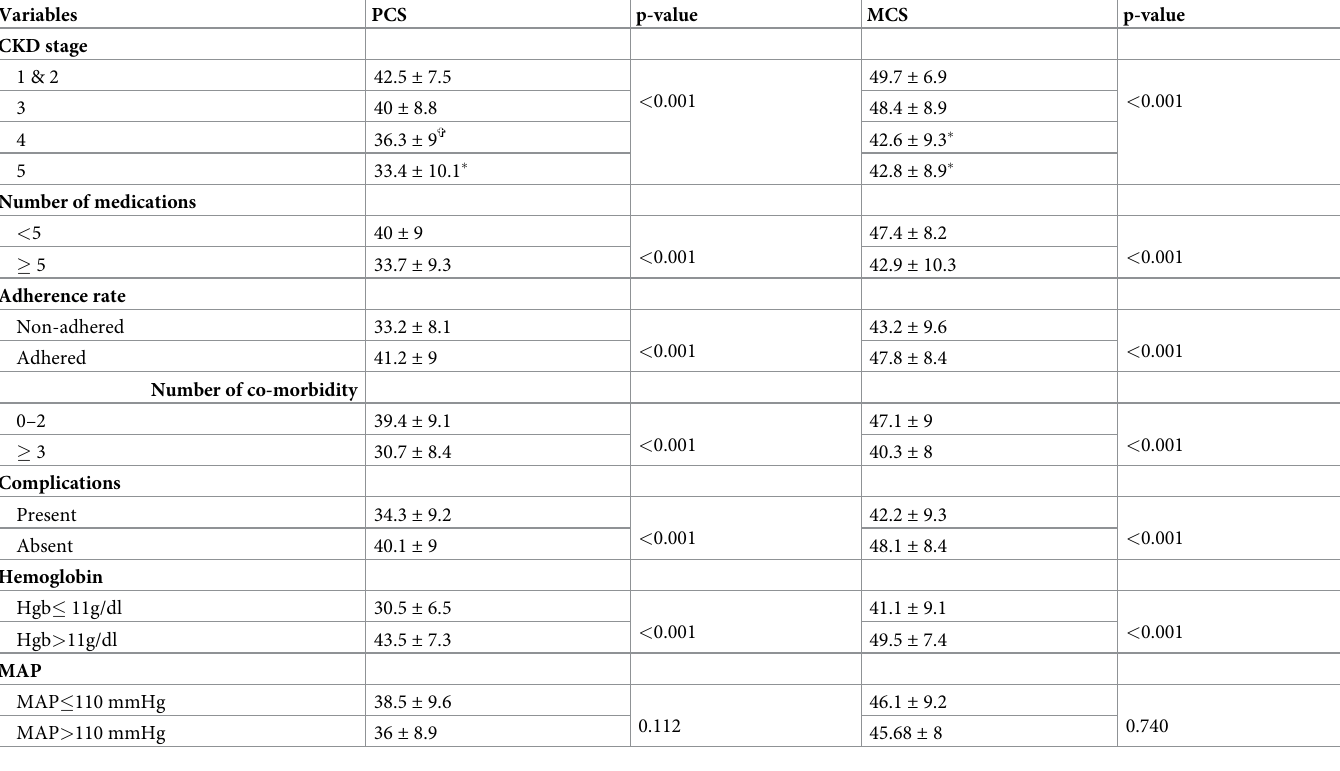
PCS = Physical summary scores, MCS = Mental summary scores, MAP = mean arterial pressure � p < 0.001 compared with CKD stage 1 & 2 ✞ p = 0.001 compared with CKD stage 1 &